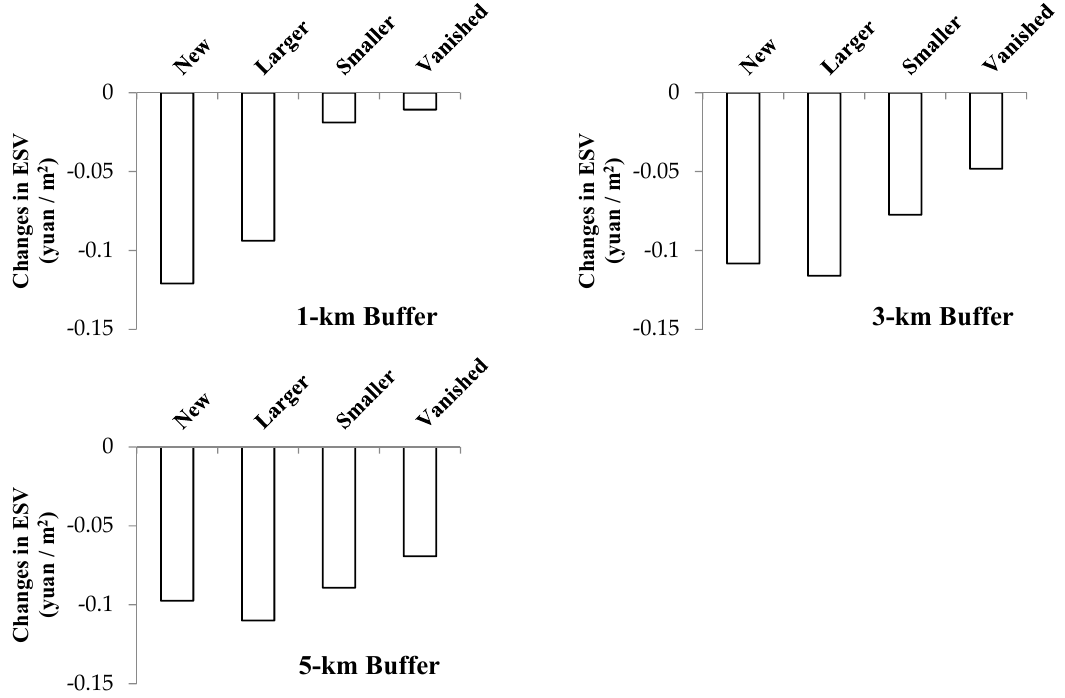
Figure 4. Changes in land ecosystems services values on surrounding land of different changing types of rural settlements .